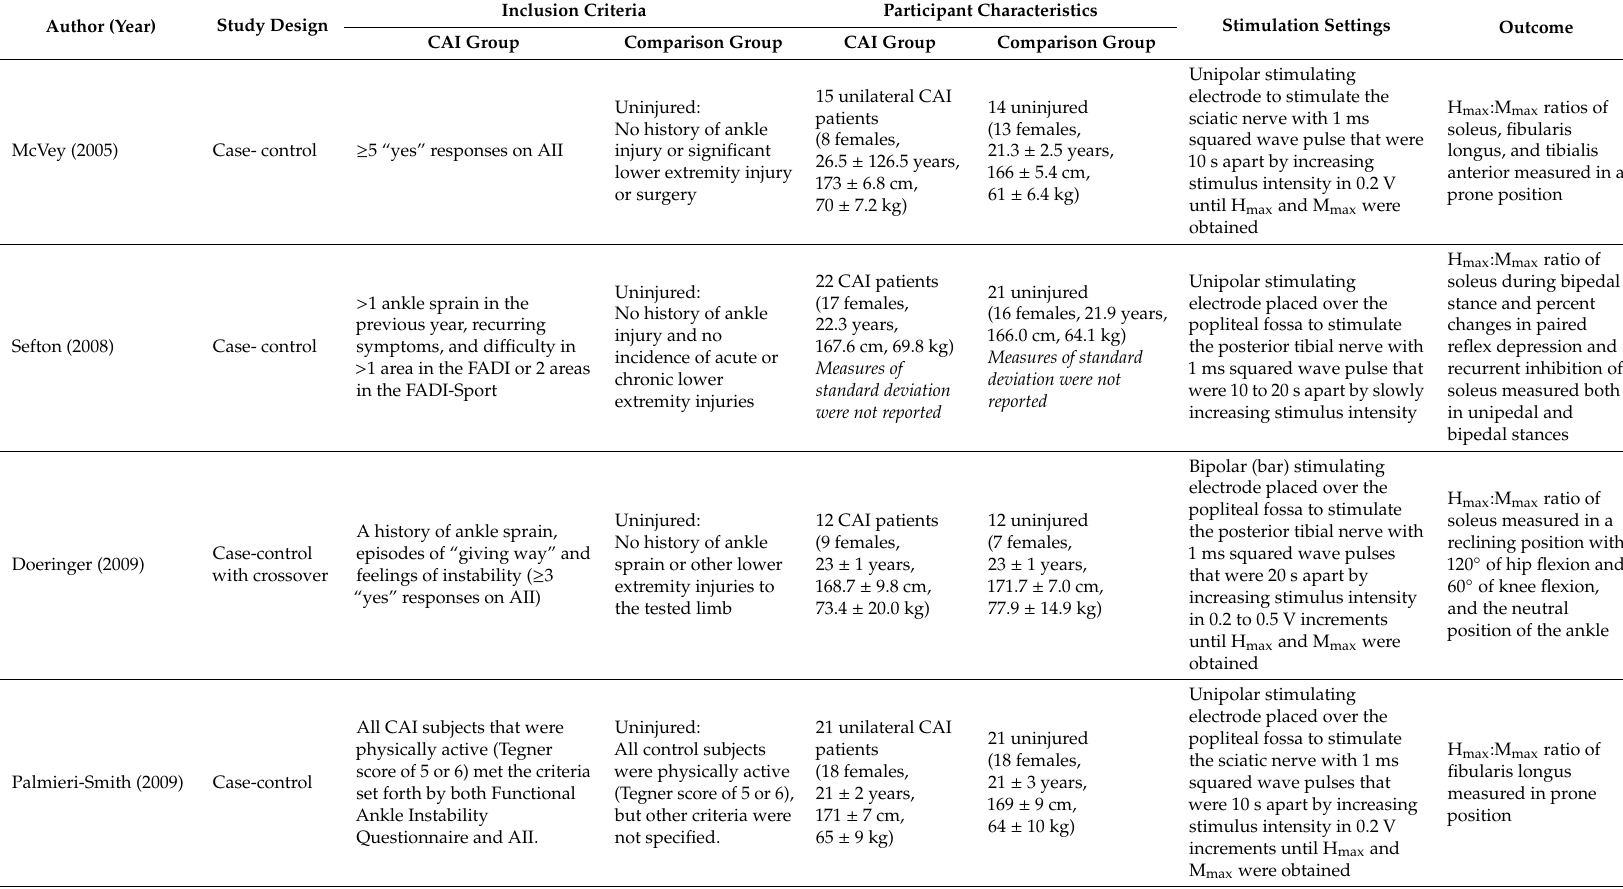
Table 1. Characteristics of included